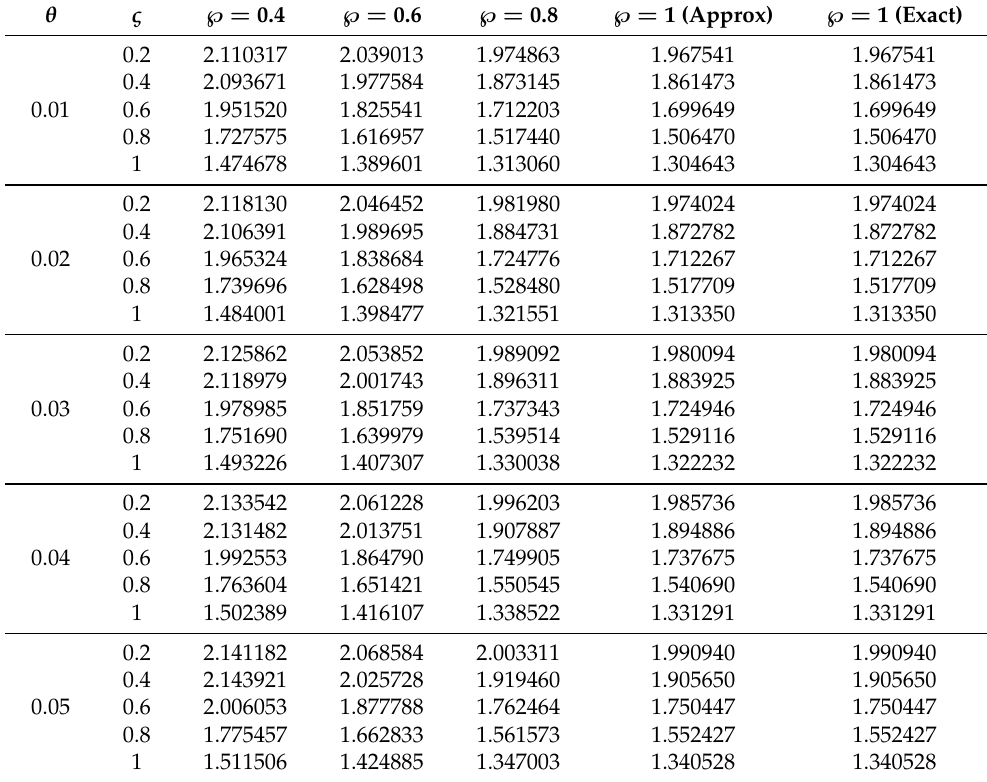
Table 2. Behavior of both the obtained approximate solution and the exact solution for various orders of ℘ are considered, for example,